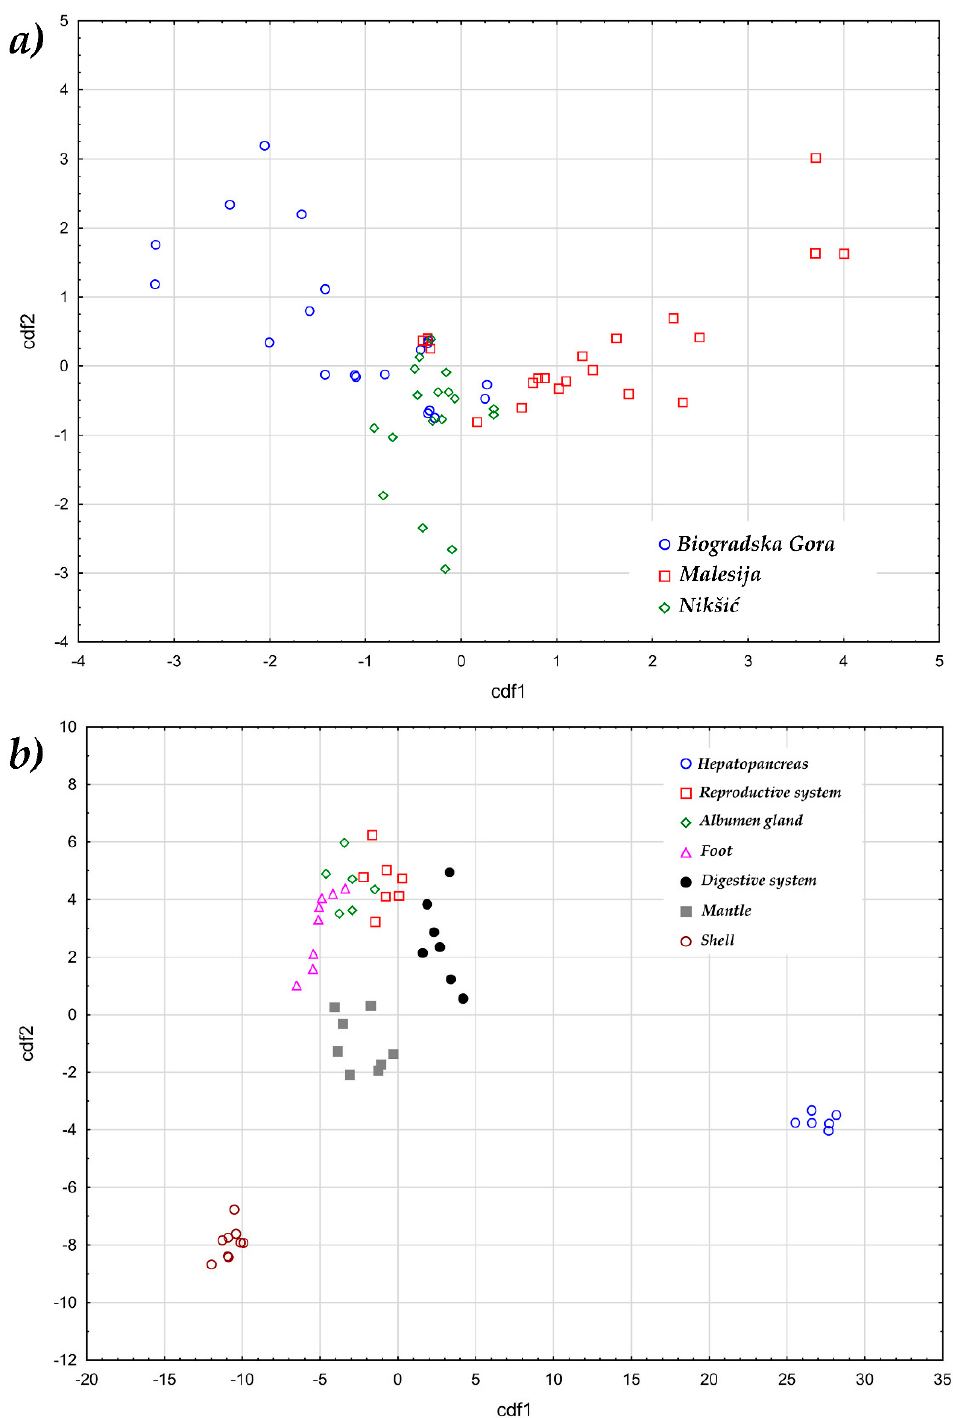
Figure 1. Canonical discriminant score plot of ( a ) examined sampling localities, and ( b ) examined snail tissues.